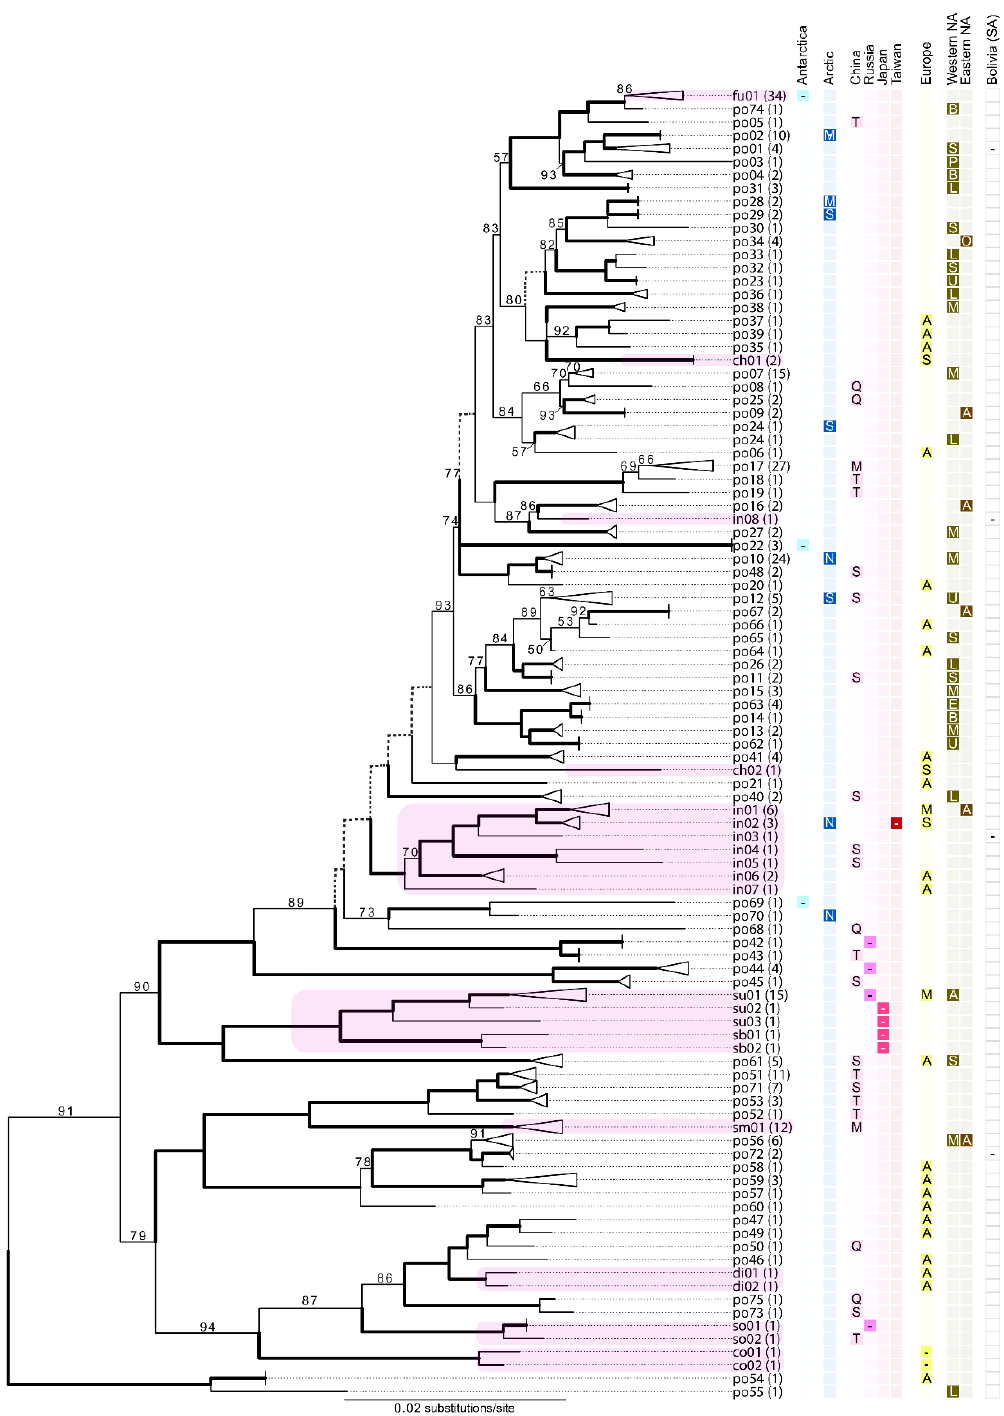
Figure 3. (previous page). Midpoint-rooted, five-marker (ITS, nuLSU, RPB 1, RPB 2, mtSSU) maximum likelihood topology of the L. polytropa group. Clades are labeled as the candidate species inferred from ITS data using ASAP, with the number of specimens representing each candidate species in parentheses. Thickened black branches indicate bootstrap (BS) values between 95–100%, dashed lines indicate BS values below 50%, and otherwise, bootstrap values are indicated at nodes. Clades highlighted in pink represent other taxa recovered in the L. polytropa clade —‘ch’, L. chlorophaeodes ; ‘co’, L. concolor ; ‘di’, L. dispersoareolata ; ‘fu’, L. fuscobrunnea ; ‘in’, L. intricata ; ‘sb’, L. cf. sub- cintula ’; ‘sm’, L. somervelii ; ‘so’, L. solaris ; ‘su’, L. subintricata — tips labels coincide with names in Sup- plementary File S1 in the ‘Candidate ASAP species partition code’ column. The geographic distri- bution of each candidate species is shown following the tip label: Antarctica (no distinction for